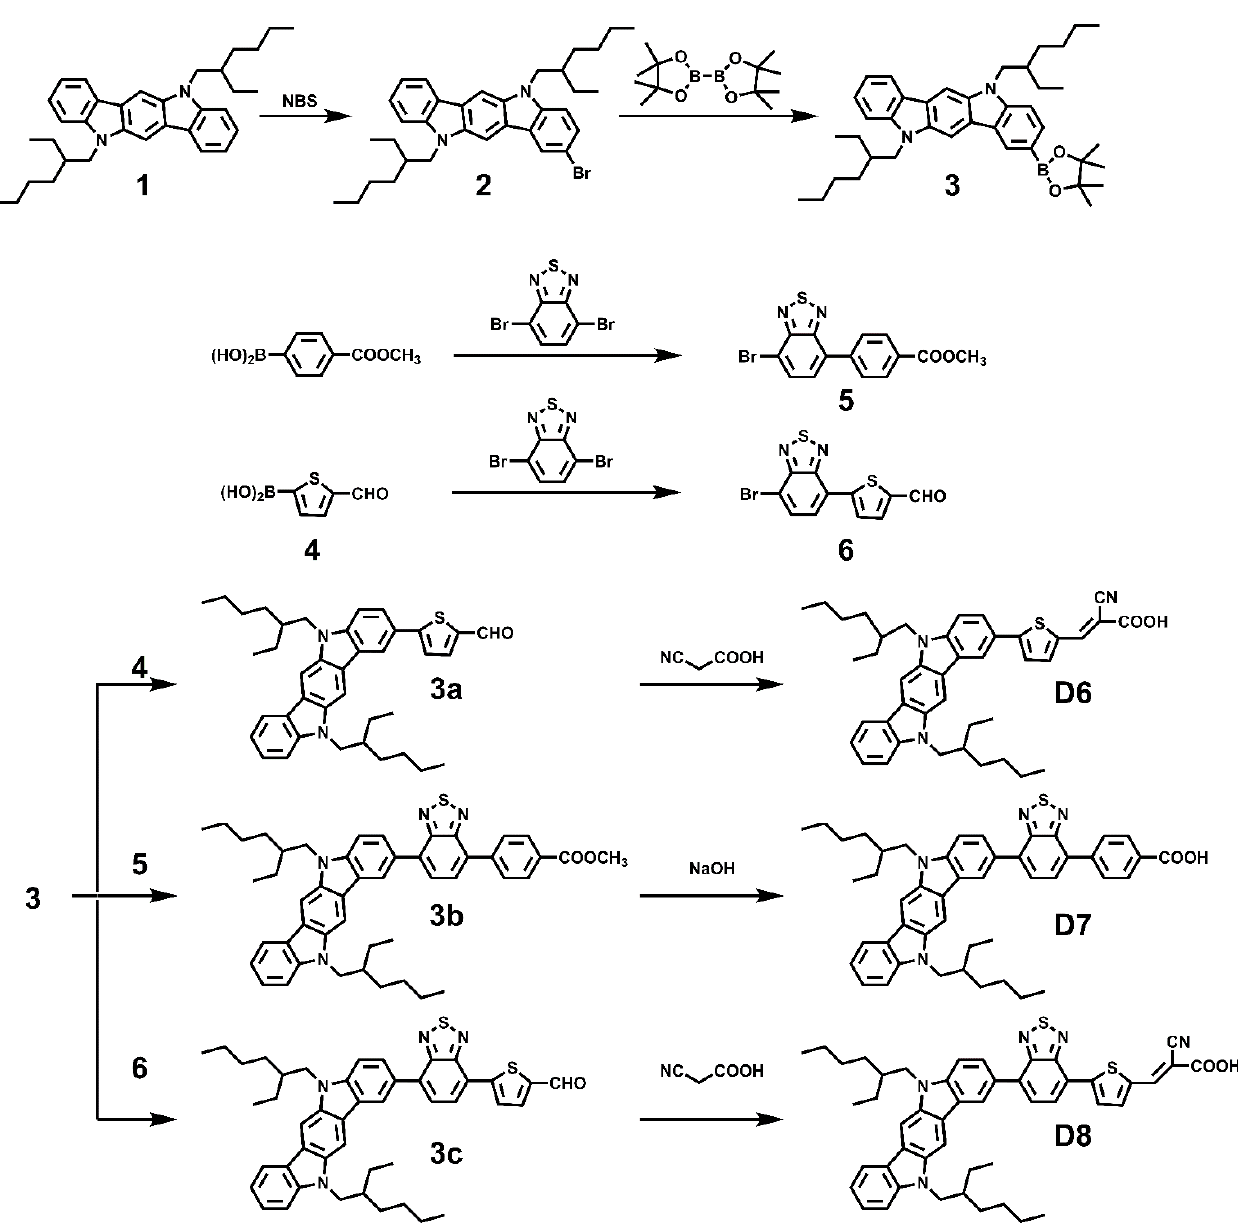
Scheme 1. Synthetic routes of the